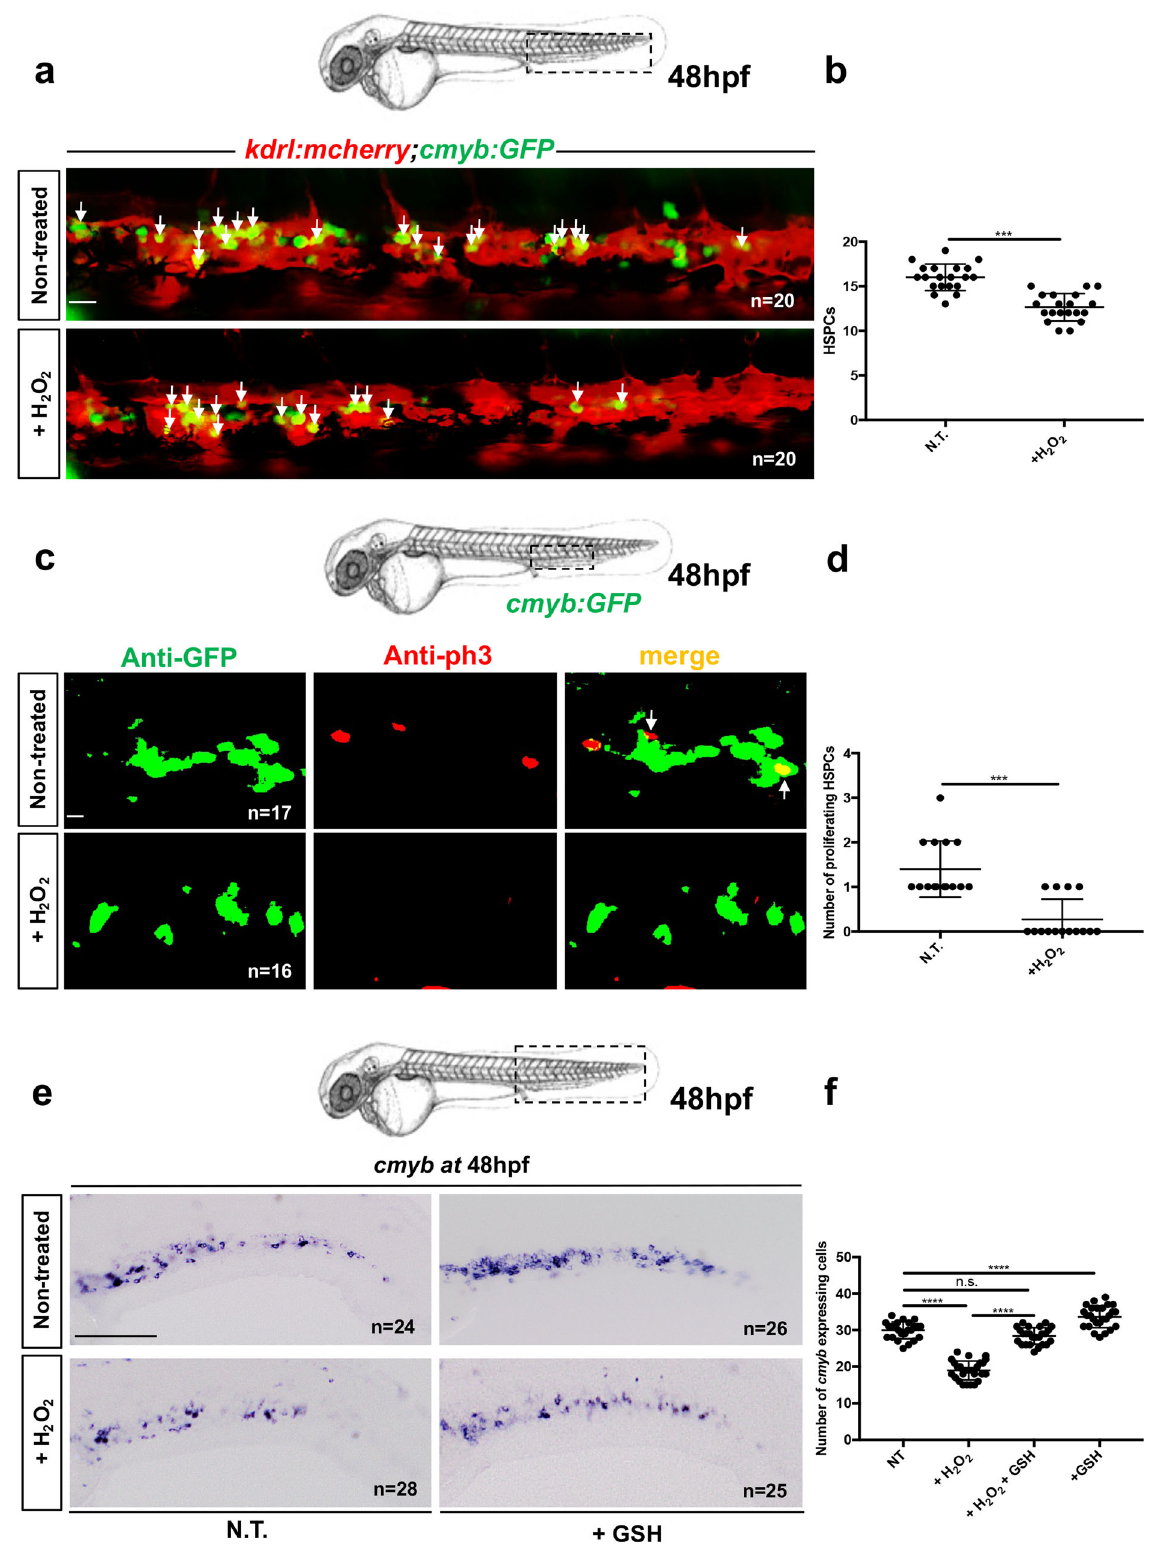
Fig. 1 Oxidative stress induces a defect in HSPC proliferation in the CHT niche at 48 hpf. a Confocal imaging in the CHT of 48 hpf kdrl:mCherry/cmyb:GFP embryos. Embryos non-treated (NT) or incubated with H 2 O 2 (3mM). b Quanti fi cation of HSPCs associated with ECs. Statistical analysis: unpaired two-tailed t test, *** P <0.001. Center values denote the mean, and error values denote s.e.m. c Anti-GFP and pH3 immunostaining of NT or H 2 O 2 -treated (3mM) cmyb:GFP embryos. d Quanti fi cation of proliferating HSPCs; statistical analysis: unpaired two-tailed t test, *** P <0.001. Center values denote the mean, and error values denote s.e.m. e cmyb expression at 48hpf in NT embryos, and embryos treated with H 2 O 2 (3mM) or GSH (10 µ m). f Quanti fi cation of cmyb- expressing cells in the CHT at 48 hpf. Statistical analysis was performed using a one-way ANOVA with Tukey – Kramer post hoc tests, adjusted for multiple comparison, **** P < 0.0001; (n.s.) non-signi fi cant P = 0.15. Center values denote the mean, and error values denote s.e.m. Scale bars: 50 μ m ( a ); 25 μ m ( c ); 100 μ m ( e ). NATURE COMMUNICATIONS| (2021) 12:4484 |https://doi.org/10.1038/s41467-021-24831-0|www.nature.com/naturecommunications